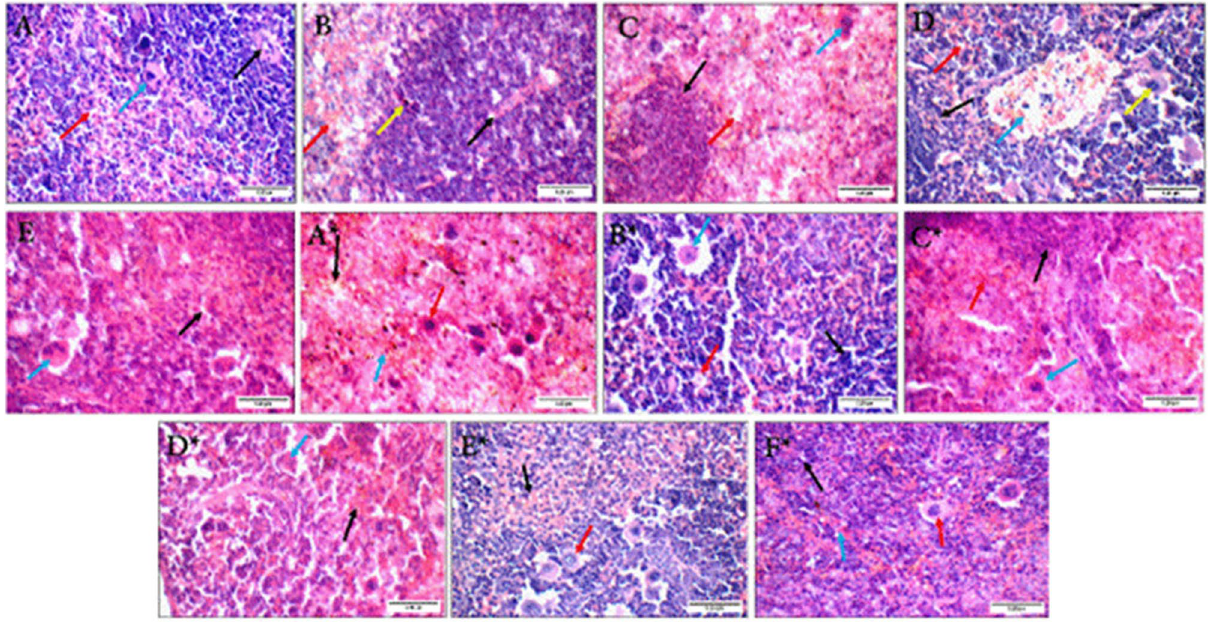
Figure 11. Spleen sections of non-infected groups: ( A ) control group showing average lymphoid follicles (white bulb) with central arterioles (black arrow), average blood sinusoids (red arrow), and scattered giant cells (blue arrow), ( B ) BV group showing average lymphoid follicles (black arrow) with scattered apoptotic cells (yellow arrow), and mildly congested blood sinusoids (red arrow), ( C ) irradiated BV group showing average lymphoid follicles (black arrow), average blood sinusoids (red arrow), and excess giant cells (blue arrow), ( D ) CS-NPs group showing average lymphoid follicles (black arrow), average blood sinusoids (red arrow), mildly congested blood vessels (blue arrow), and excess giant cells (yellow arrow), ( E ) BV-loaded CS-NPs group showing average blood sinusoids (black arrow), and scattered giant cells (blue arrow). Spleen sections of infected groups with S. aureus : ( A* ) no treatment group showing markedly congested blood sinusoids (red arrow), scattered apoptotic cells (blue arrow), and excess giant cells (black arrow), ( B* ) BV group showing average lymphoid follicles (black arrow), average blood sinusoids (red arrow), and excess giant cells (blue arrow), ( C* ) irradiated BV group showing small-sized lymphoid follicles (black arrow), congested blood sinusoids (red arrow), and scattered giant cells (blue arrow), ( D* ) CS-NPs showing mildly congested blood sinusoids (black arrow), and scattered giant cells (blue arrow), ( E* ) BV-loaded CS-NPs showing average blood sinusoids (black arrow), and excess giant cells (red arrow), ( F* ) antibiotic group showing average lymphoid follicles (black arrow), average blood sinusoids (blue arrow), and excess giant cells (red arrow) (H&E × 400). BV: Bee venom, CS-NPs: Chitosan nanoparticles, BV-loaded CS-NPs: Bee venom loaded Chitosan nanoparticles, S. aureus: Staphylococcus aureus, H&E: Hematoxylin and